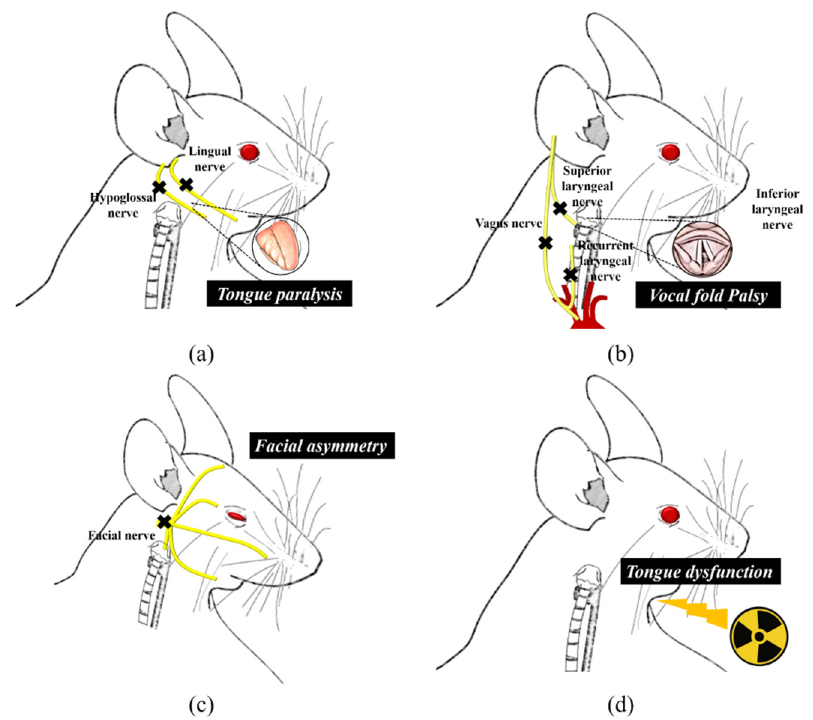
Figure 2. Rodent model of oropharyngeal dysphagia caused by various injuries. ( a ) unilateral lingual paralysis by hypoglossal nerve injury, ( b ) vocal fold paralysis by laryngeal or vagus nerve injury, ( c ) facial palsy by facial nerve injury, ( d ) tongue dysfunction by irradiation of head and neck regions.